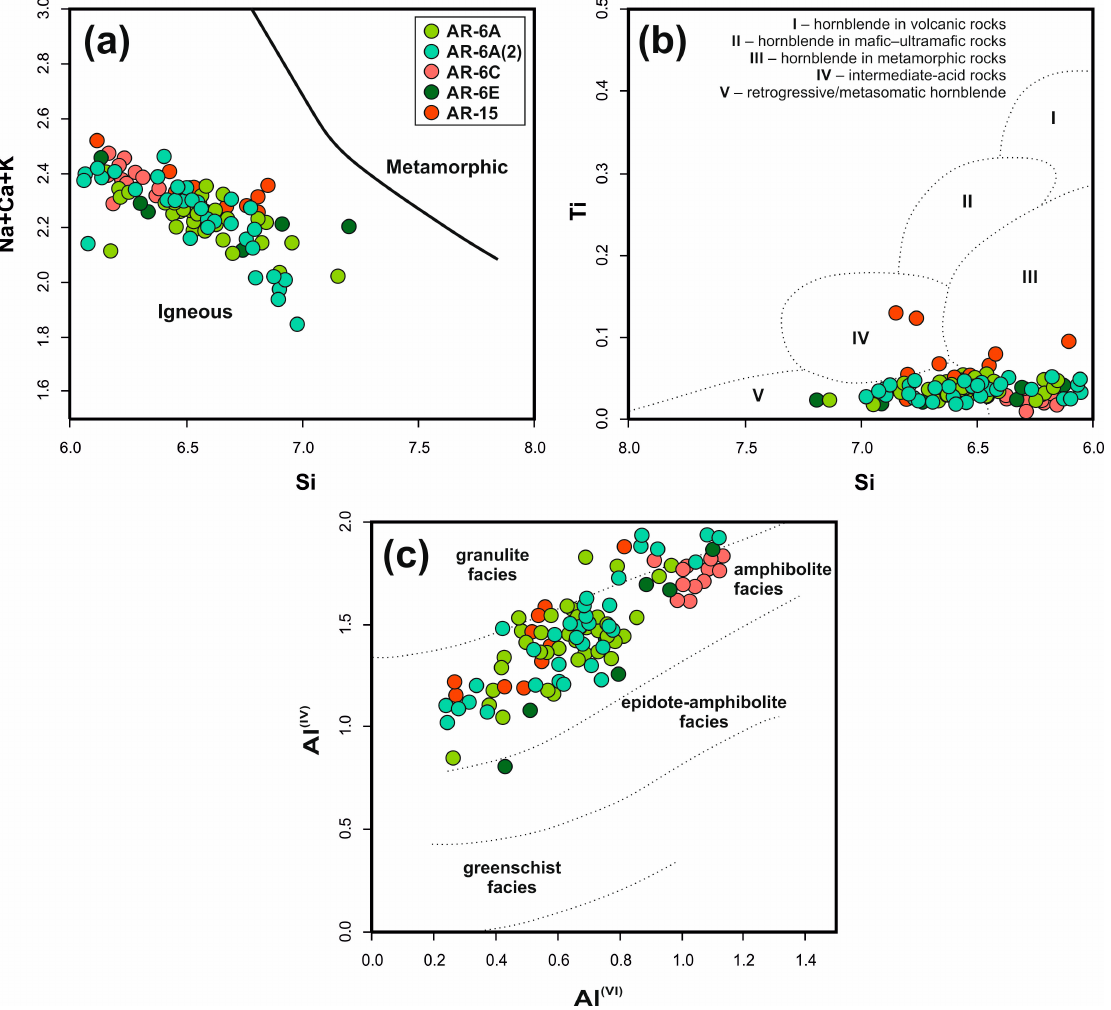
Figure 8. Discrimination diagrams for hornblendes from the Aravalli area ortoamphibolites. ( a ) Na + Ca + K vs. Si diagram, ( b ) Si vs. Ti diagram for hornblendes after [36], ( c ) Al VI vs. Al IV diagram after [37].